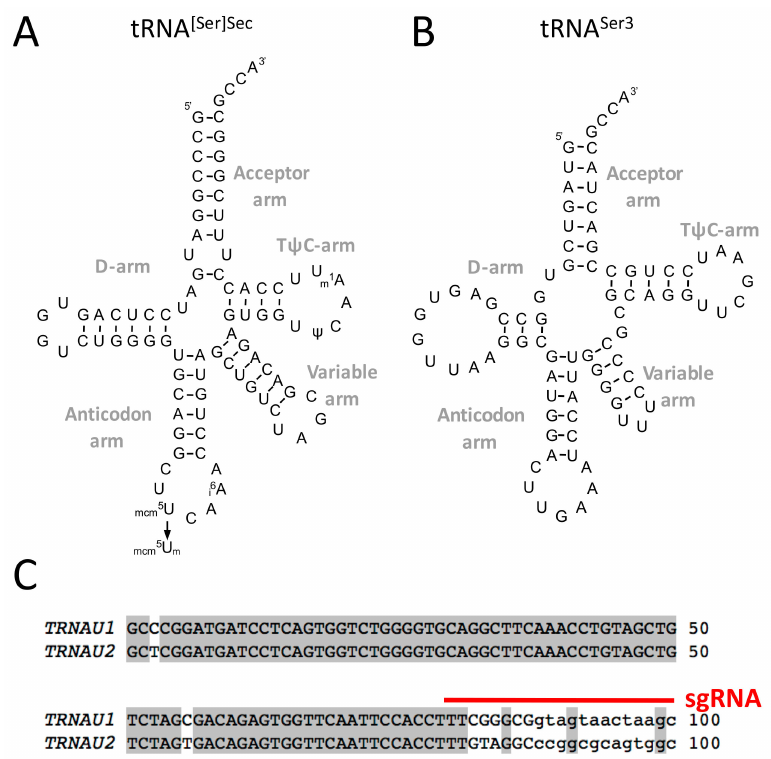
Figure 1. The tRNA [Ser]Sec , two-dimensional structure, modification, and comparison to tRNA Ser3 and its pseudogene. Two-dimensional structure representation of tRNA [Ser]Sec encoded by TRNAU1 gene ( A ) and tRNA Ser3 ( B ). ( C ) Sequence alignment of human TRNAU1 and TRNAU2 genes, located in chromosome 19 and 22, respectively. The common nucleotides are represented in grey, otherwise in white. The region targeted by the sgRNA is shown with a red